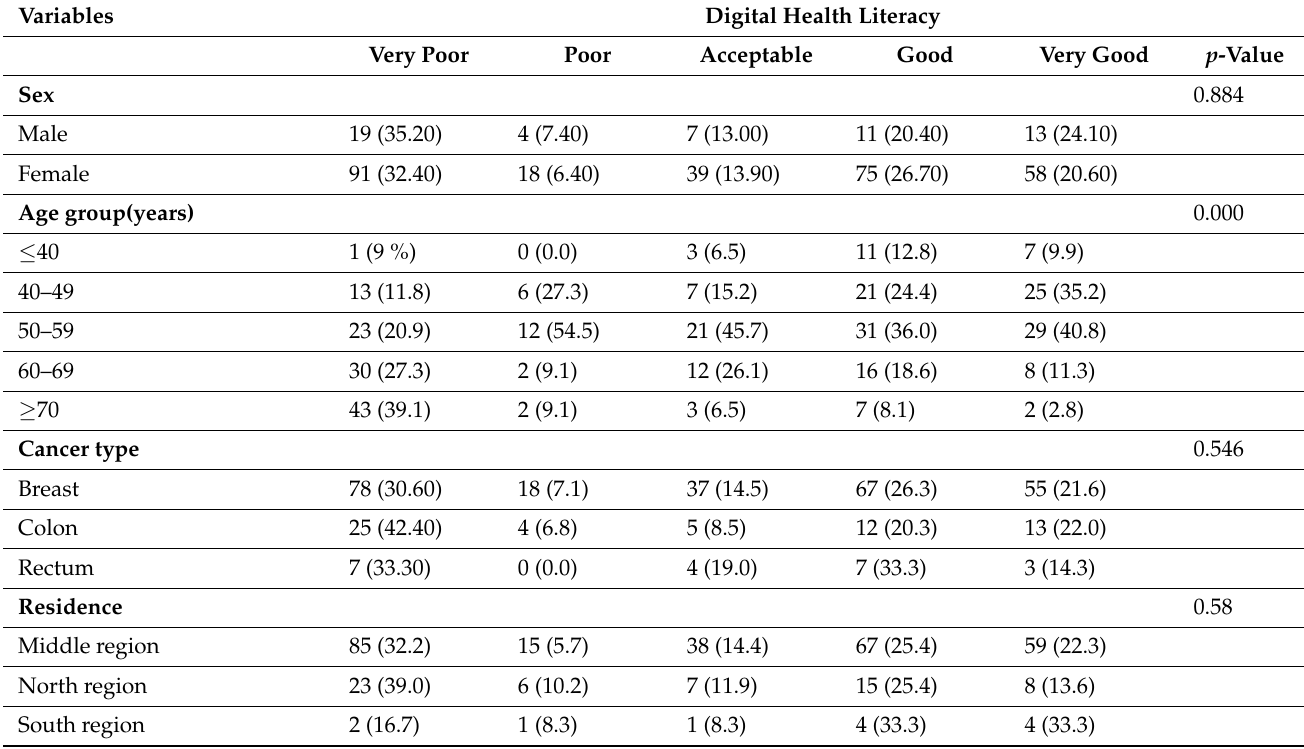
Table 4. Association between demographic characteristics and digital literacy of breast and colorec- tal